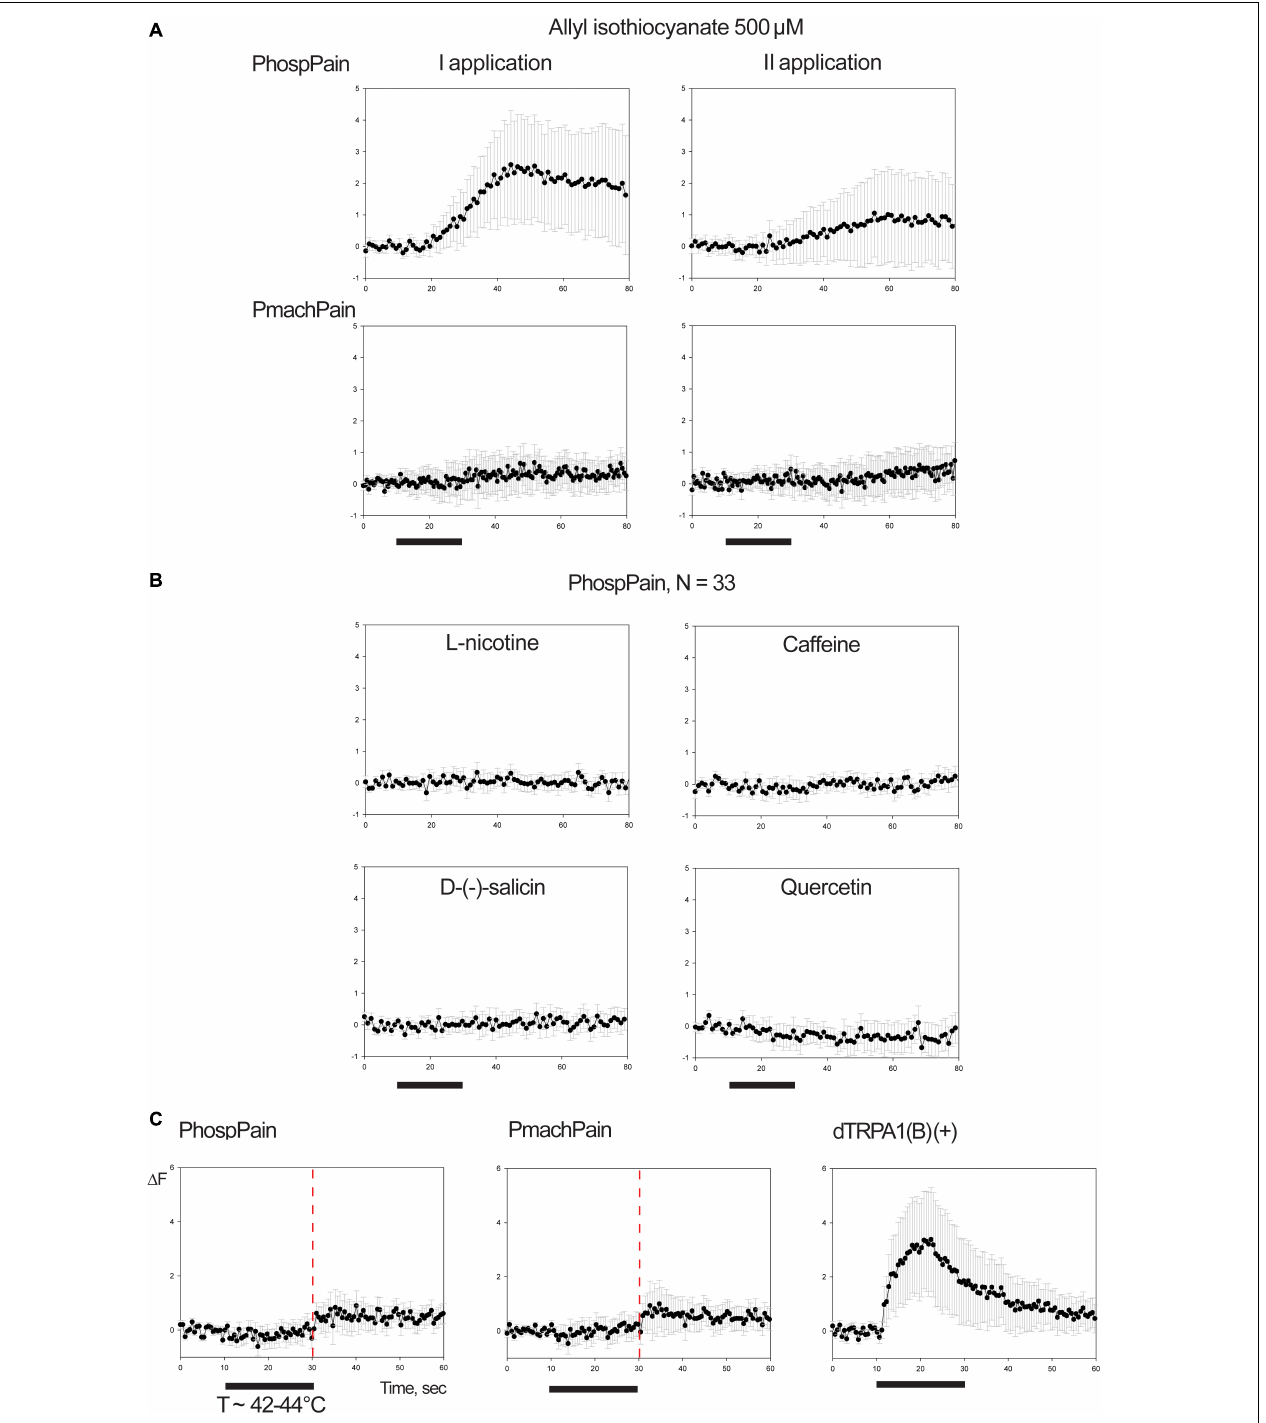
FIGURE 7 | Functional studies on TRP Painless. (A) Mean ± SE of fluorescence variation associated with PhospPain ( N = 33) and PmachPain ( N = 28) upon stimulation with 500 µ M allyl-isothiocyanate (AITC, two consecutive applications). (B) Application of 500 µ M doses of L-nicotine, caffeine, D-(-)-salicin, quercetin on HEK-cells transfected with PhospPain that were found responsive to AITC. Black bars: stimulus (20 s). (C) Mean ± SE of fluorescence variation associated with PhospPain ( N = 94) and PmachPain ( N = 107) upon stimulation with heat (T ∼ 42–44 ◦ C). Right: positive control experiment stimulating HEK293A cells transfected with dTRPA1(B) ( N = 101). Red line: time point for thermal experiments preceding an endogenous-effect observed in the phase of testing HEK-cells transfected for Papilio Painless. The demonstrated Ca ++ -dependency of this effect on HEK cells (Ong et al., 2015; Shalygin et al., 2015) may associate the activation of cation channels most probably belonging to the asset of thermal-gated channels selective for Calcium (Xiao et al., 2011).